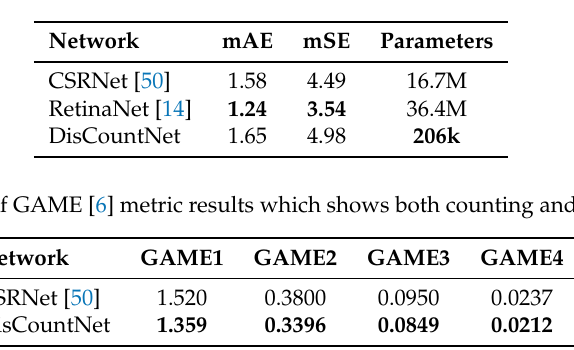
Table 1. A base comparison between state-of-the-art networks and our DisCountNet method for counting errors.